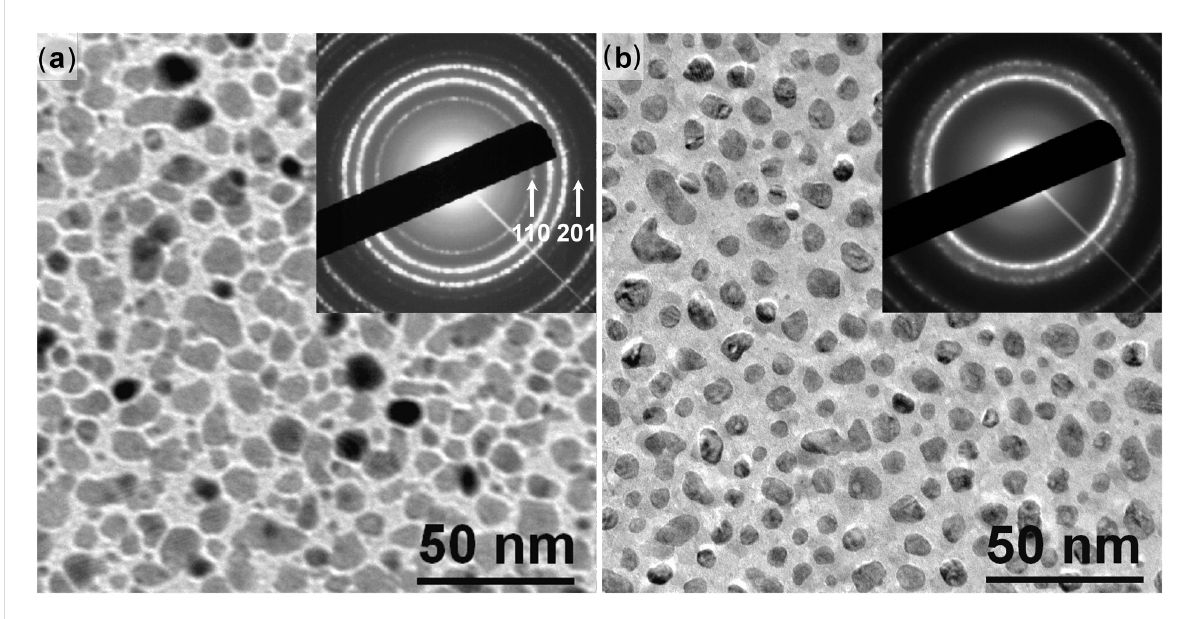
Figure 3: Evolution of the CoPt NPs size, shape, and crystalline structure during flash laser annealing. TEM images and the corresponding diffraction pattern (inset), (a) as-grown CoPt NPs in the L1 0 ordered structure, (b) after 3 laser pulses, CoPt NPs in the FCC disordered structure.